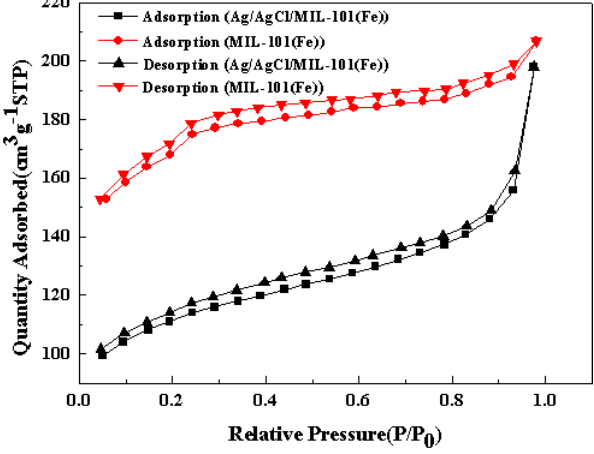
Figure 1. X ‐ ray diffraction patterns of the Ag/AgCl, MIL ‐ 101(Fe) and Ag/AgCl/MIL ‐ 101(Fe). Figure 1. X-ray di ff raction patterns of the Ag / AgCl, MIL-101(Fe) and Ag / AgCl / MIL-101(Fe).